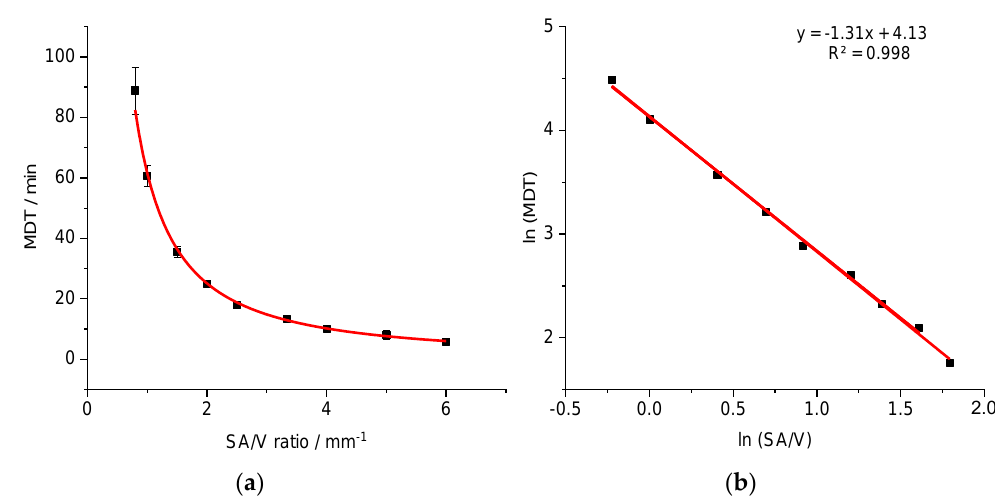
Figure 3. Correlation of MDT and SA/V ratio for the PVA-PDM formulation ( a ) and linearized version ( b ) ( n ≥ 3; x ± s).